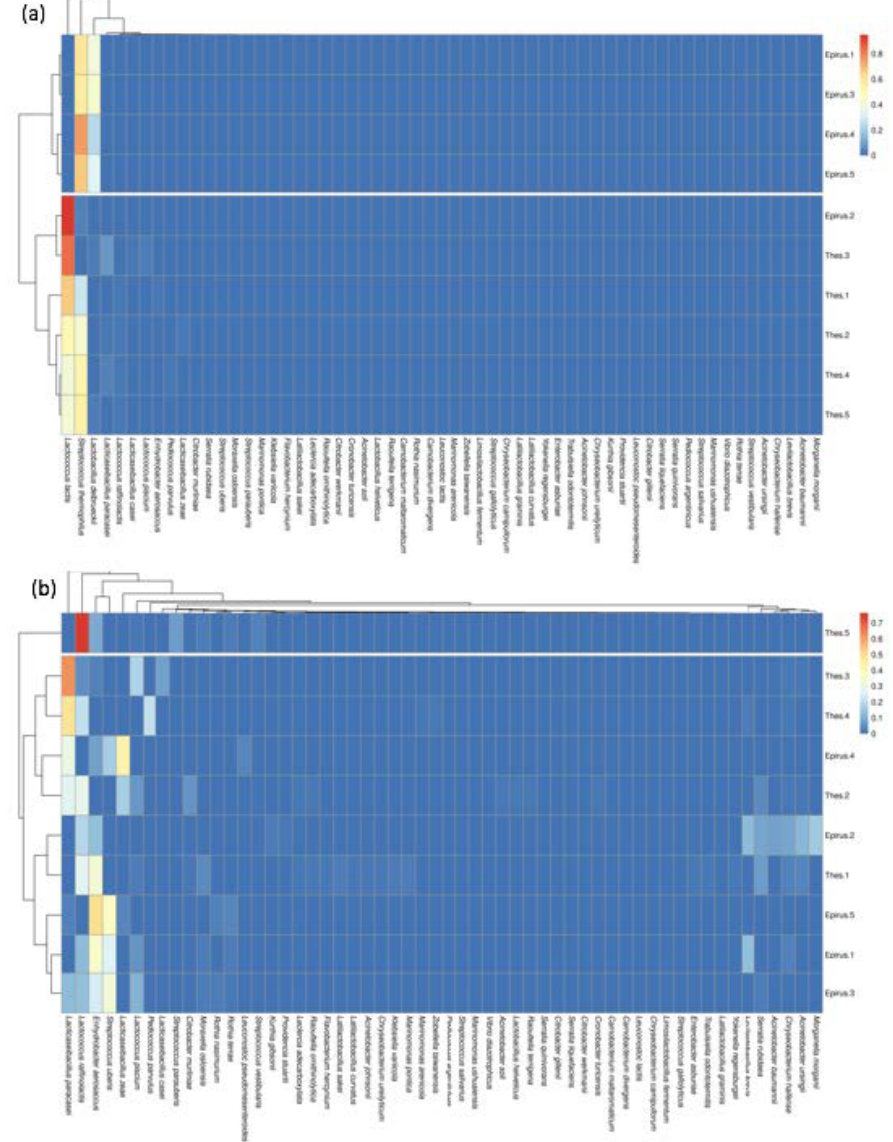
Figure 6. Heatmap of the abundance values that each sample has among the species. The cells of the heatmap are colored according to the abundance. ( a ) The graph produced with all the species in the analysis. ( b ) The graph produced after the three major species were removed from the